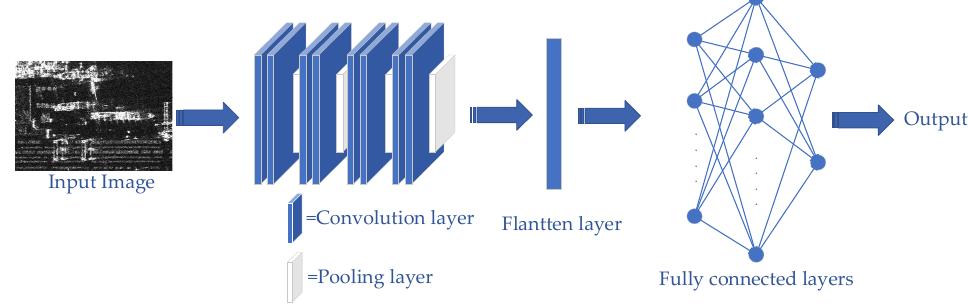
Figure 6. CNN basic architecture diagram.